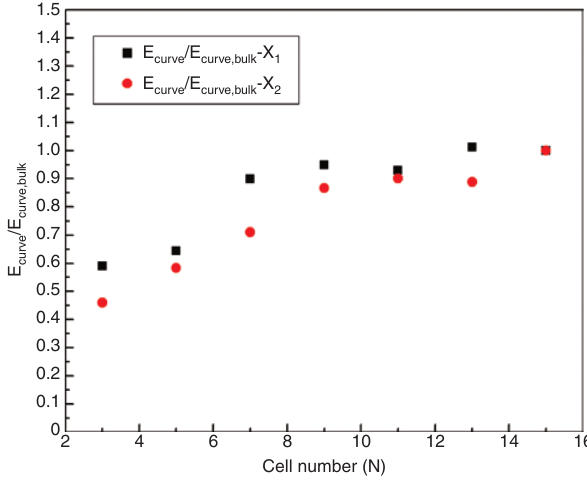
Figure 7 The curve modulus of seven kinds of honeycomb speci- mens with different in-plane size, normalized by the bulk value, plotted against cell number, N .